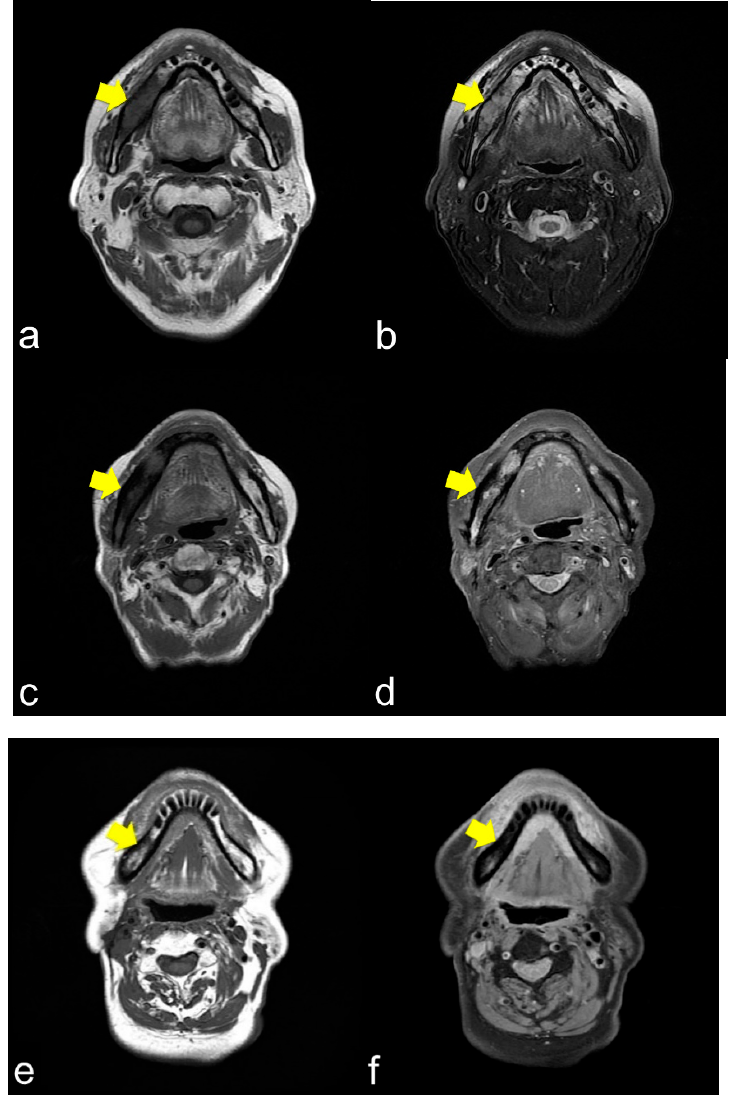
Figure 2. ( a ) Axial T1-weight image (T1 WI) shows low signal intensity from the molar lesion to the ramus on right side of the mandible (arrowhead); ( b ) Axial T2-weight image (T2 WI) reveals high signal intensity on the right side of the mandible (arrowhead). The margins between the normal and abnormal bone marrow are not distinct. This condition usually shows mild inflammation of the ORN; ( c ) Axial T1 WI shows low signal intensity from the molar lesion to the ramus on the right side of the mandible (arrowhead); ( d ) Axial T2 WI reveals heterogeneous intensity on the right side of the mandible (arrowhead). The margins between the normal and abnormal bone marrow are not distinct. This condition usually results in severe ORN inflammation; ( e ) Axial T1 WI shows low signal intensity from the molar lesion to the ramus on the right side of the mandible (arrowhead); ( f ) Axial T2 WI reveals low signal intensity on the right side of the mandible (arrowhead). The margins between the normal and abnormal bone marrow are not distinct. This condition is bone necrosis, which shows less inflammation.